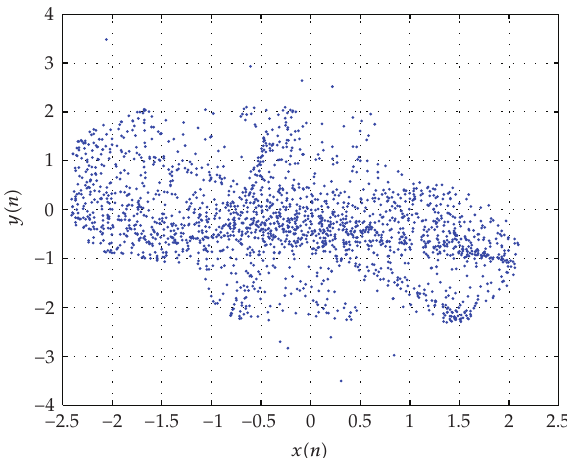
Figure 5: Phase portrait of the chaotic attractor (cid:5) x n ,y n (cid:6)